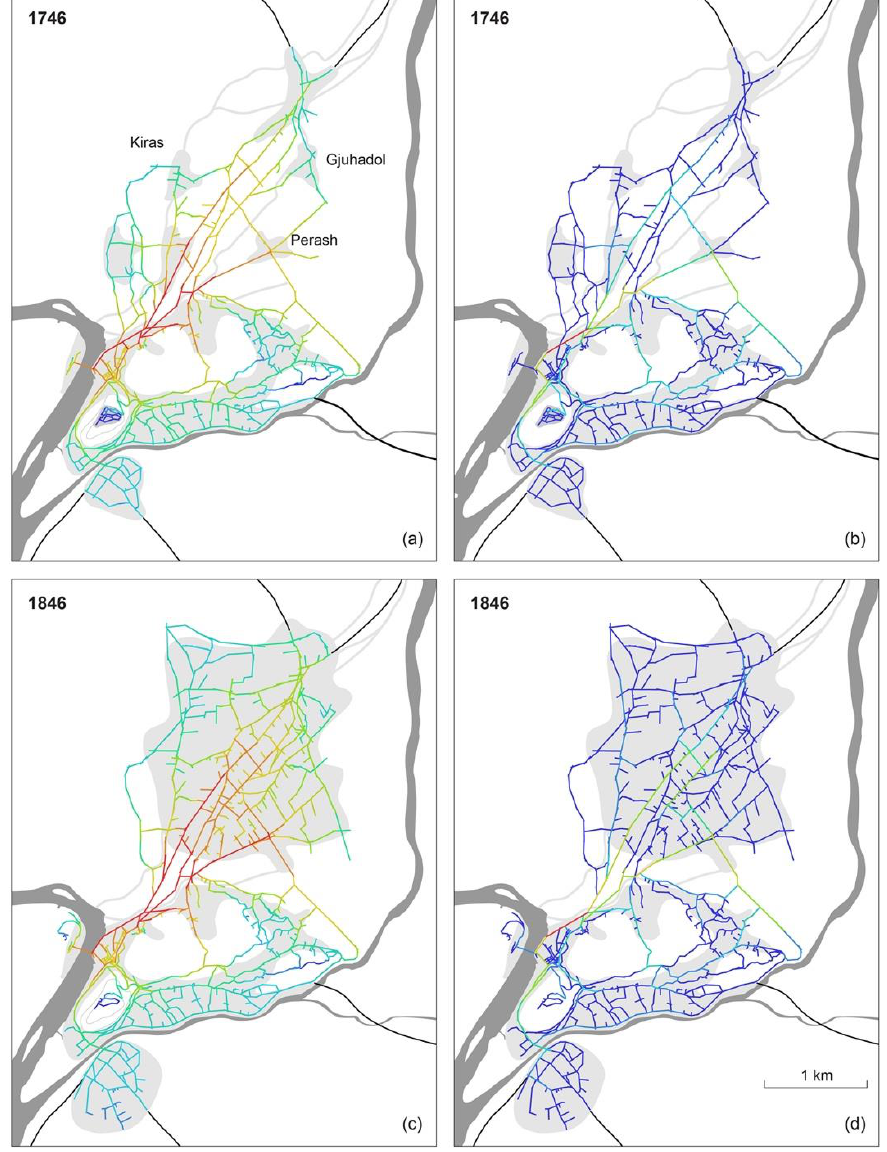
Figure 4 Axial map of Shkodër’s street network during the middle Ottoman period (1746) and (1846) colored according to values of integration (a, c) and choice (b,